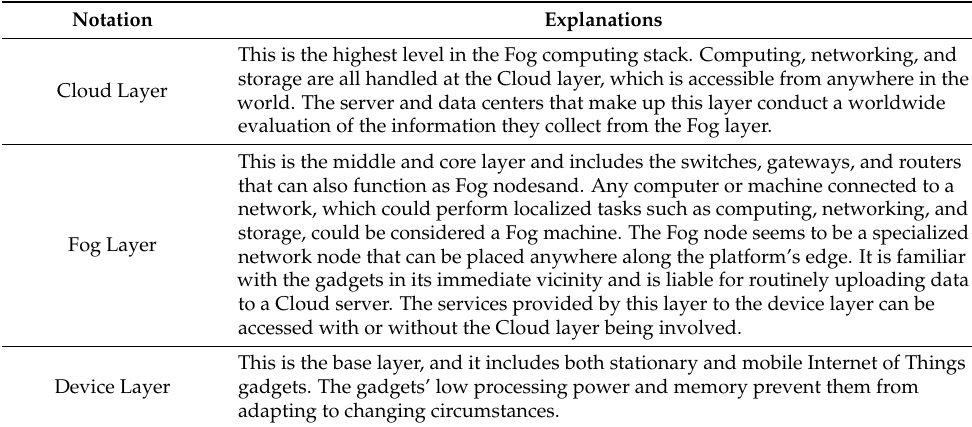
Table 3. Fog computing infrastructure